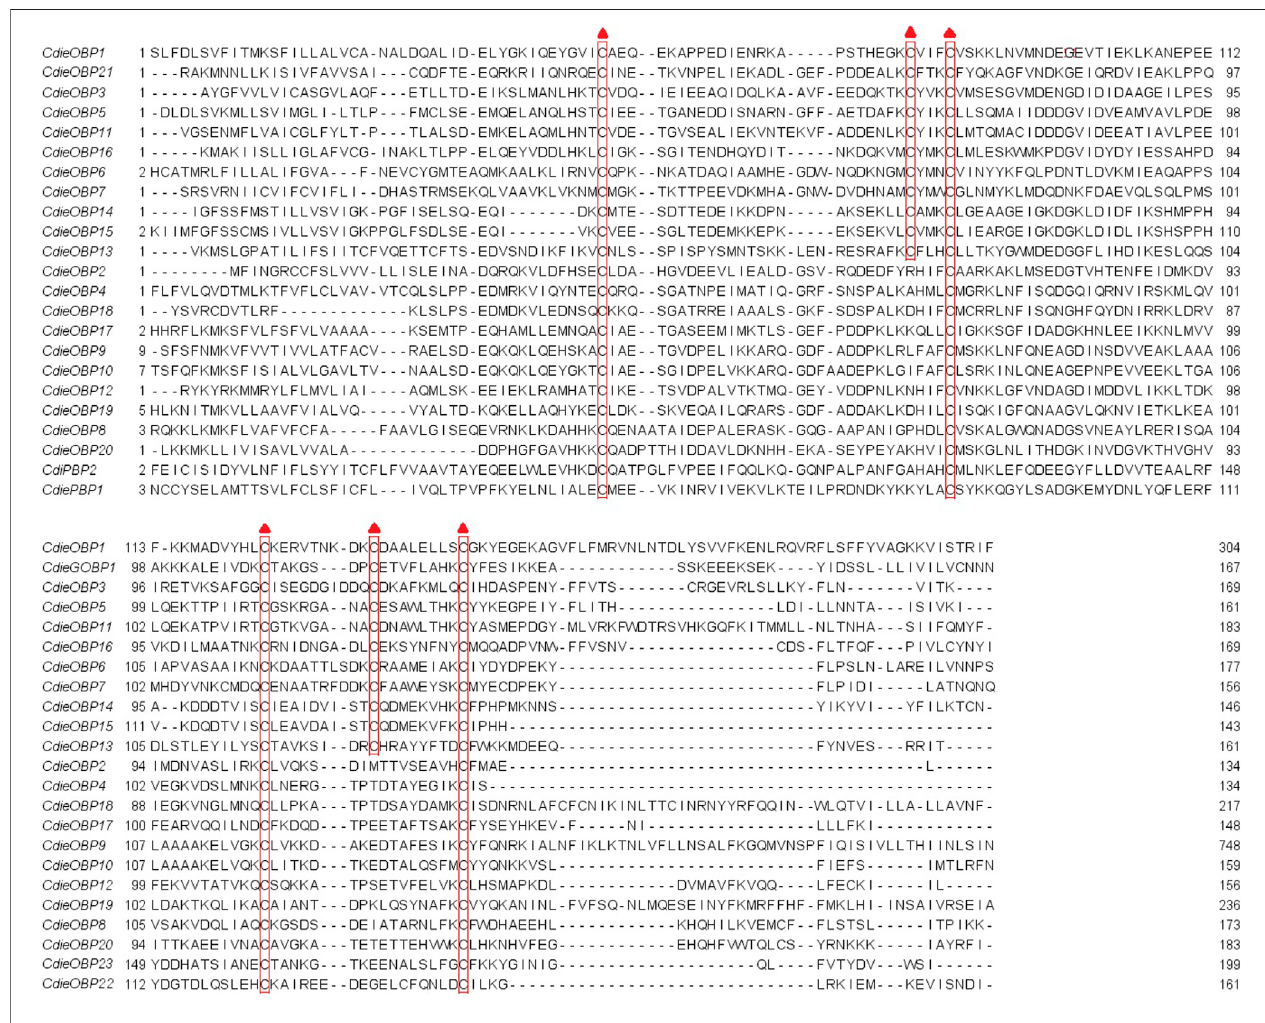
FIGURE 1 | Alignment of candidate OBPs of C. dieckmanni. The highly conserved cysteine residues are marked with red triangles.